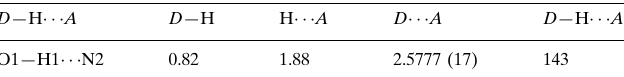
Hydrogen-bond geometry (A˚ , (cid:1)